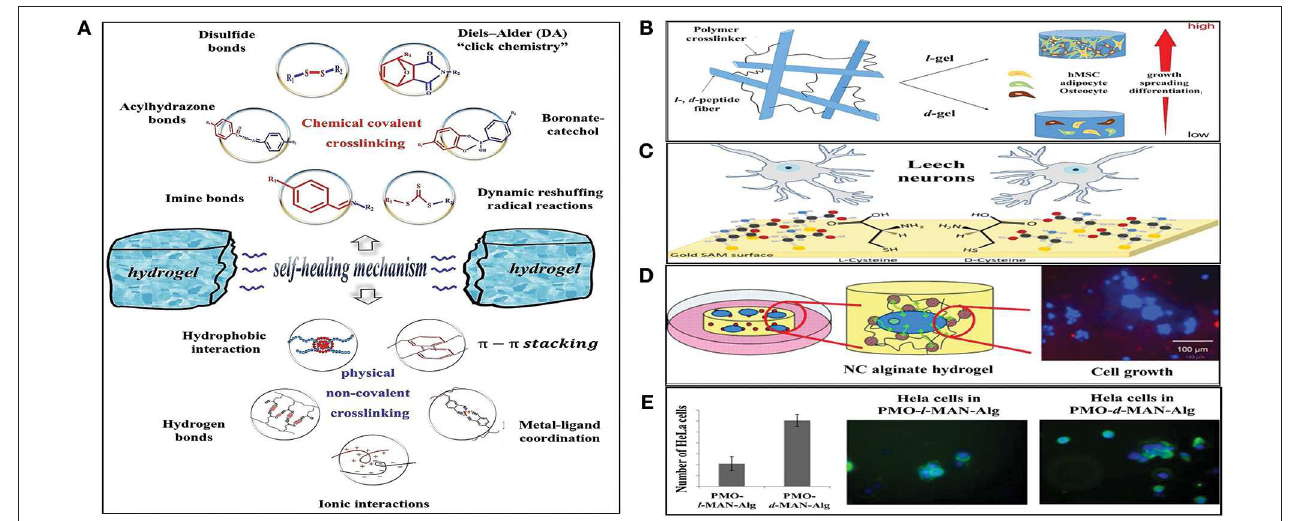
FIGURE 1 | (A) Intrinsic strategies for the preparation of self-healing hydrogels (Tu et al., 2019), adapted with permission from Elsevier. (B) Regulation of stem cell function and fate in a 3D hydrogel network with chiral motifs (Zheng et al., 2018), reprinted with permission from American Chemical Society (ACS). (C) Effect of l- and d-cysteine on single neuronal growth ( Baranes et al., 2014), adapted with permission from American Chemical Society (ACS). (D) Nanocomposite alginate hydrogels incorporated with Dye-loaded periodic mesoporous organosilica particles functionalized with bioactive molecules (Kehr et al., 2013), adapted with permission